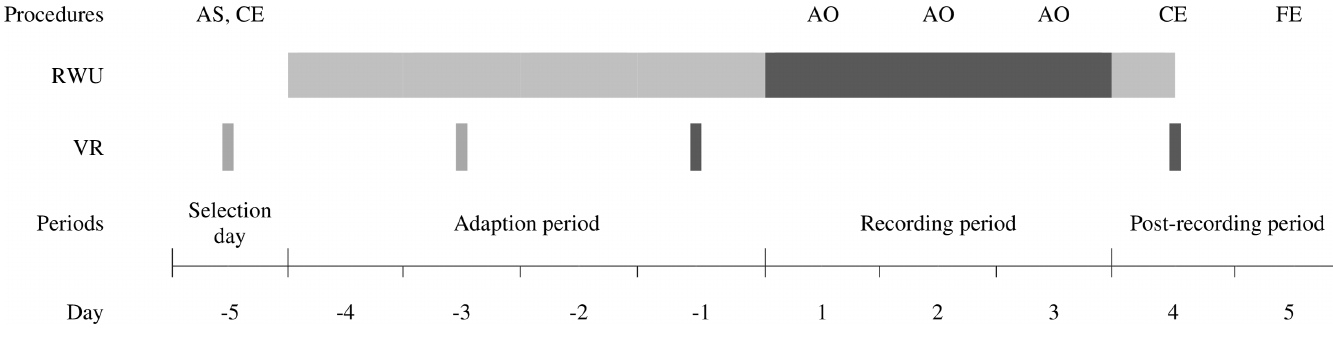
Fig 1. Schematic representation of the experimental procedure per study group. Accelerometers and noseband sensors (RumiWatch-units = RWU) are either attached (light grey) or attached and data recorded (dark grey). Video recording (VR) procedures used for habituation of study cows to the procedure are marked in light grey, VR used for lameness assessment are marked in dark grey. AS = Animal Selection, CE = clinical examination, AO = animal observation (heat, illness, gait scoring), FE = foot examination in the trimming